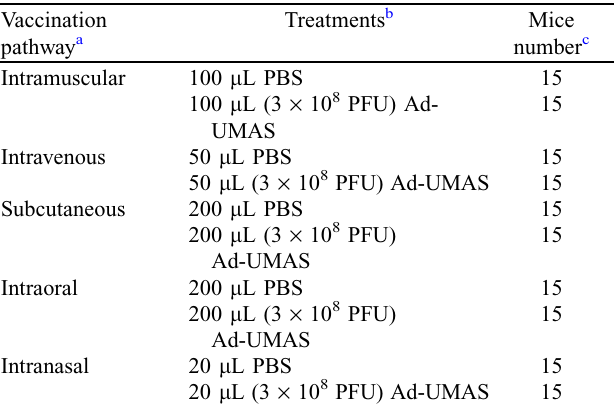
Table 1. Summary of treatments in BALB/c